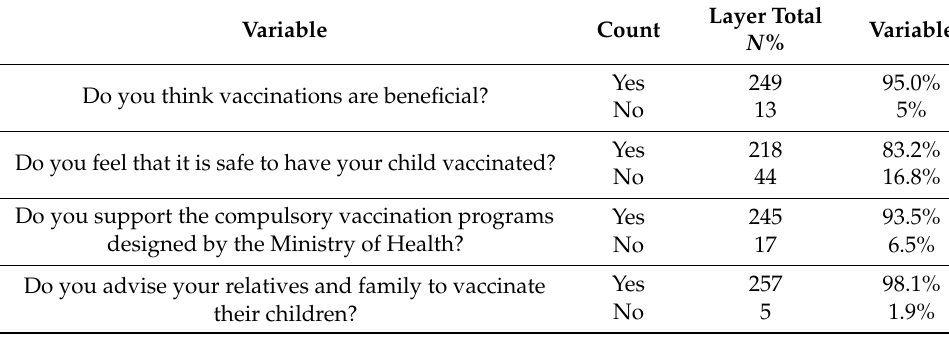
Table 3. Assessment of the mothers’ attitudes towards childhood vaccination.